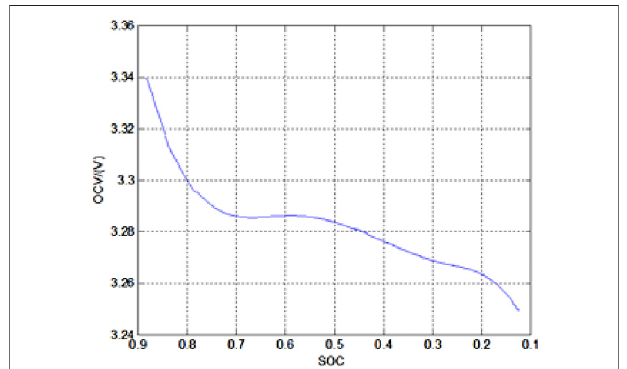
FIGURE 9 | The relationship between SOC and OCV.